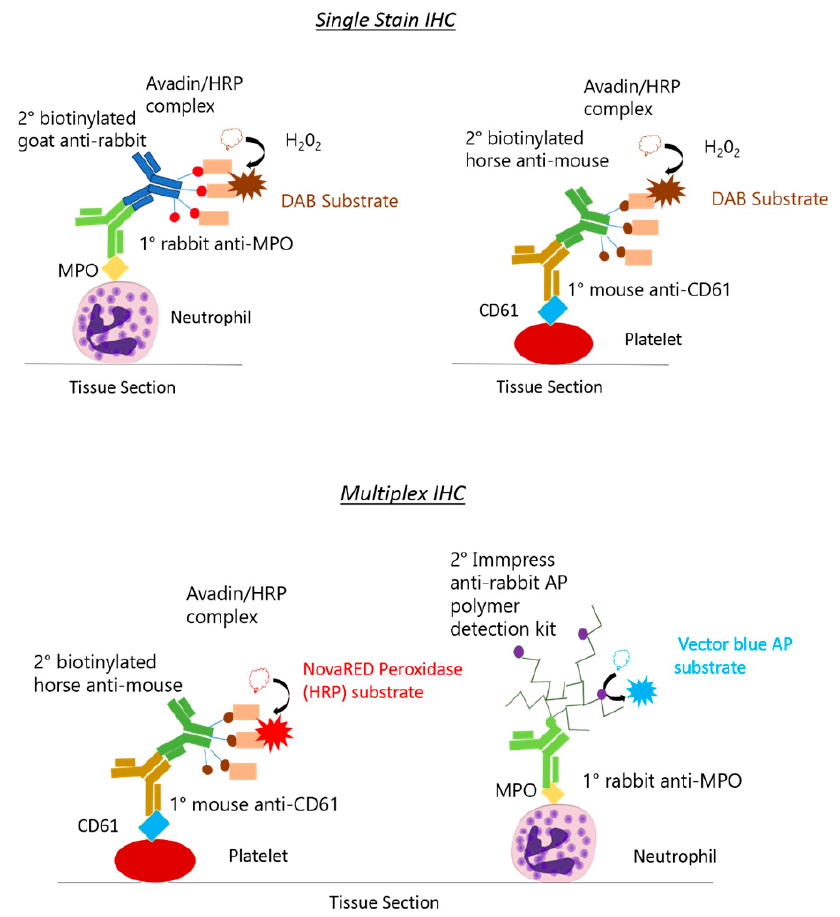
Figure 1. Schematic of single-stain and multiplex immunohistochemistry reporter systems. In single-stained immunohistochemistry (IHC) (above), neutrophils and platelets are detected in sep- arate tissue sections using a horse radish peroxidase (HRP)-dependent reporting system. The 3,3’-diaminobenzidine (DAB) substrate forms a brown precipitate in positively stained regions. In multiplex IHC (below), platelets and neutrophils can be detected in the same tissue section. Platelets are detected using a HRP-dependent reaction, whilst neutrophils are detected using an alkaline phos- phatase (AP) dependent reaction. Blue and red colour substrates allow for visualisation of colocal- ised events.